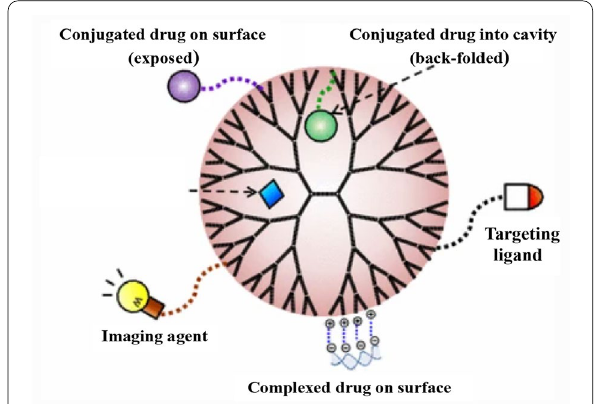
Fig. 7 Schematic representation of pharmaceutical applications of dendrimers. Referred from [164] with